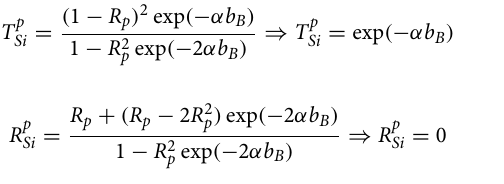
p Si is equal to 100% p Si is equal to 0 at the